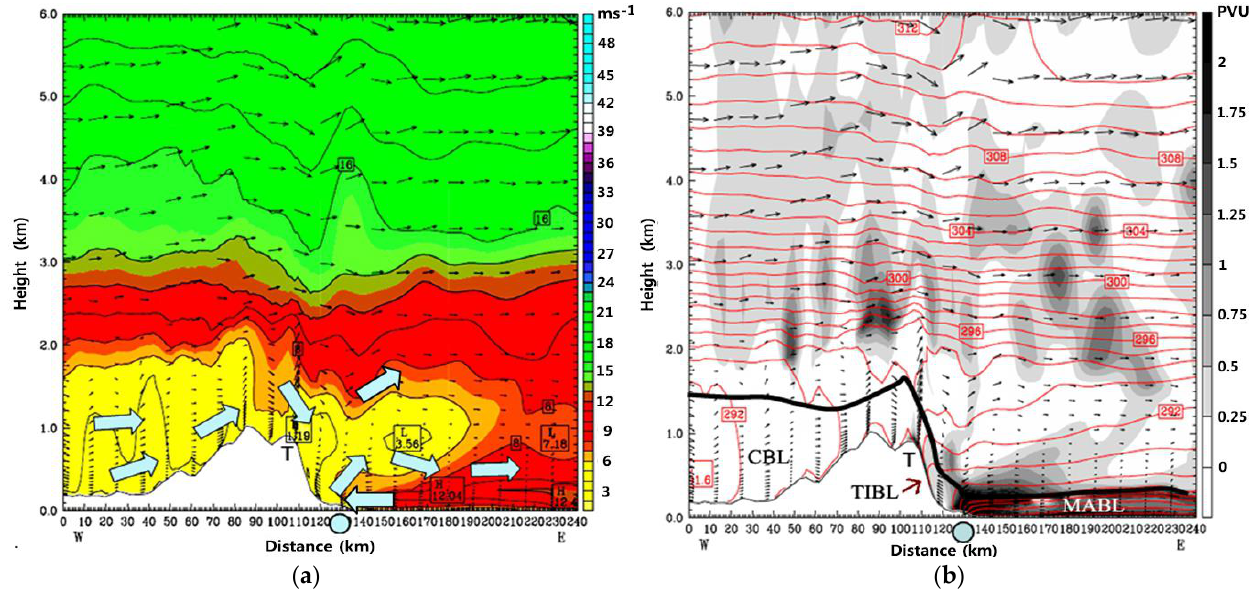
Figure 8 . Vertical profile of ( a ) horizontal wind (m/s) and ( b ) potential temperature (k) with wind speed (m/s) in the third domain at 15:00 LST, 29 March 2004. The arrow, a small circle, the thick line, CBL, TIBL, and MABL denote wind, Gangneung city, the top of the convective boundary layer, convective boundary layer, thermal internal boundary layer, and marine atmospheric boundary layer. A dark area of high potential vorticity near the coastal and open sea surfaces denotes trapped air particles, showing high PM concentrations, but the uplifting of particulates in the TIBL toward a big cavity over the city in ( a ) causes a PM concentration near the city surface.